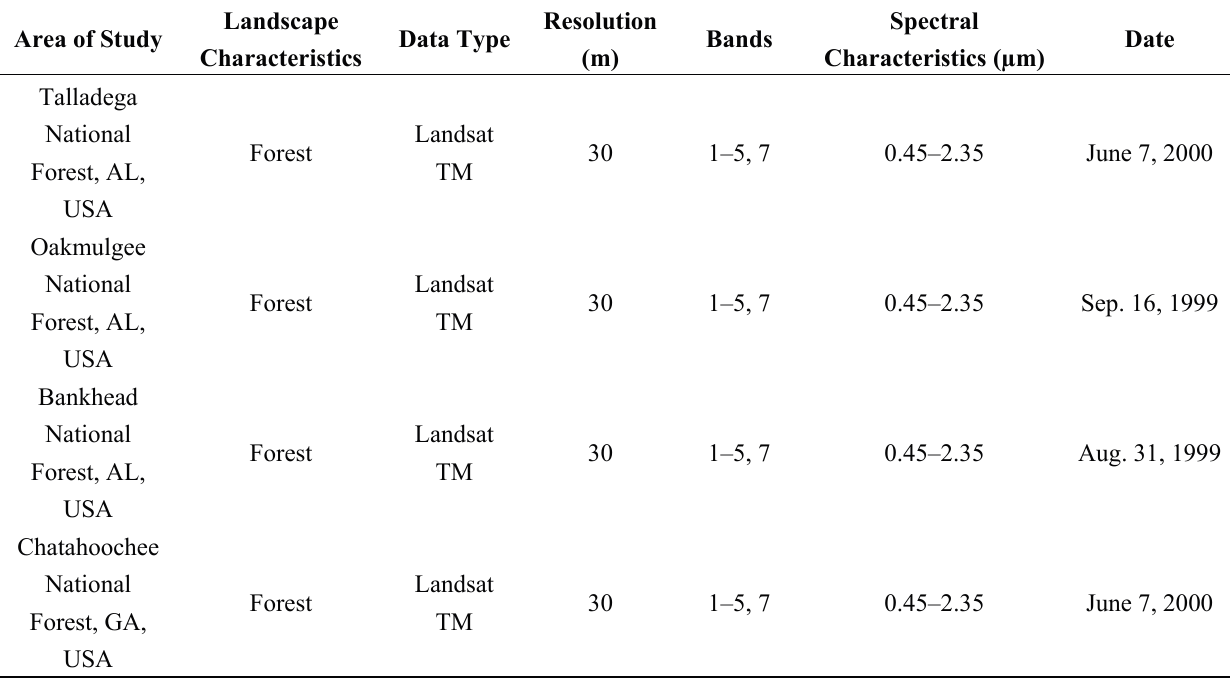
Table 1. Characteristics of the Landsat Data Used in the Study.